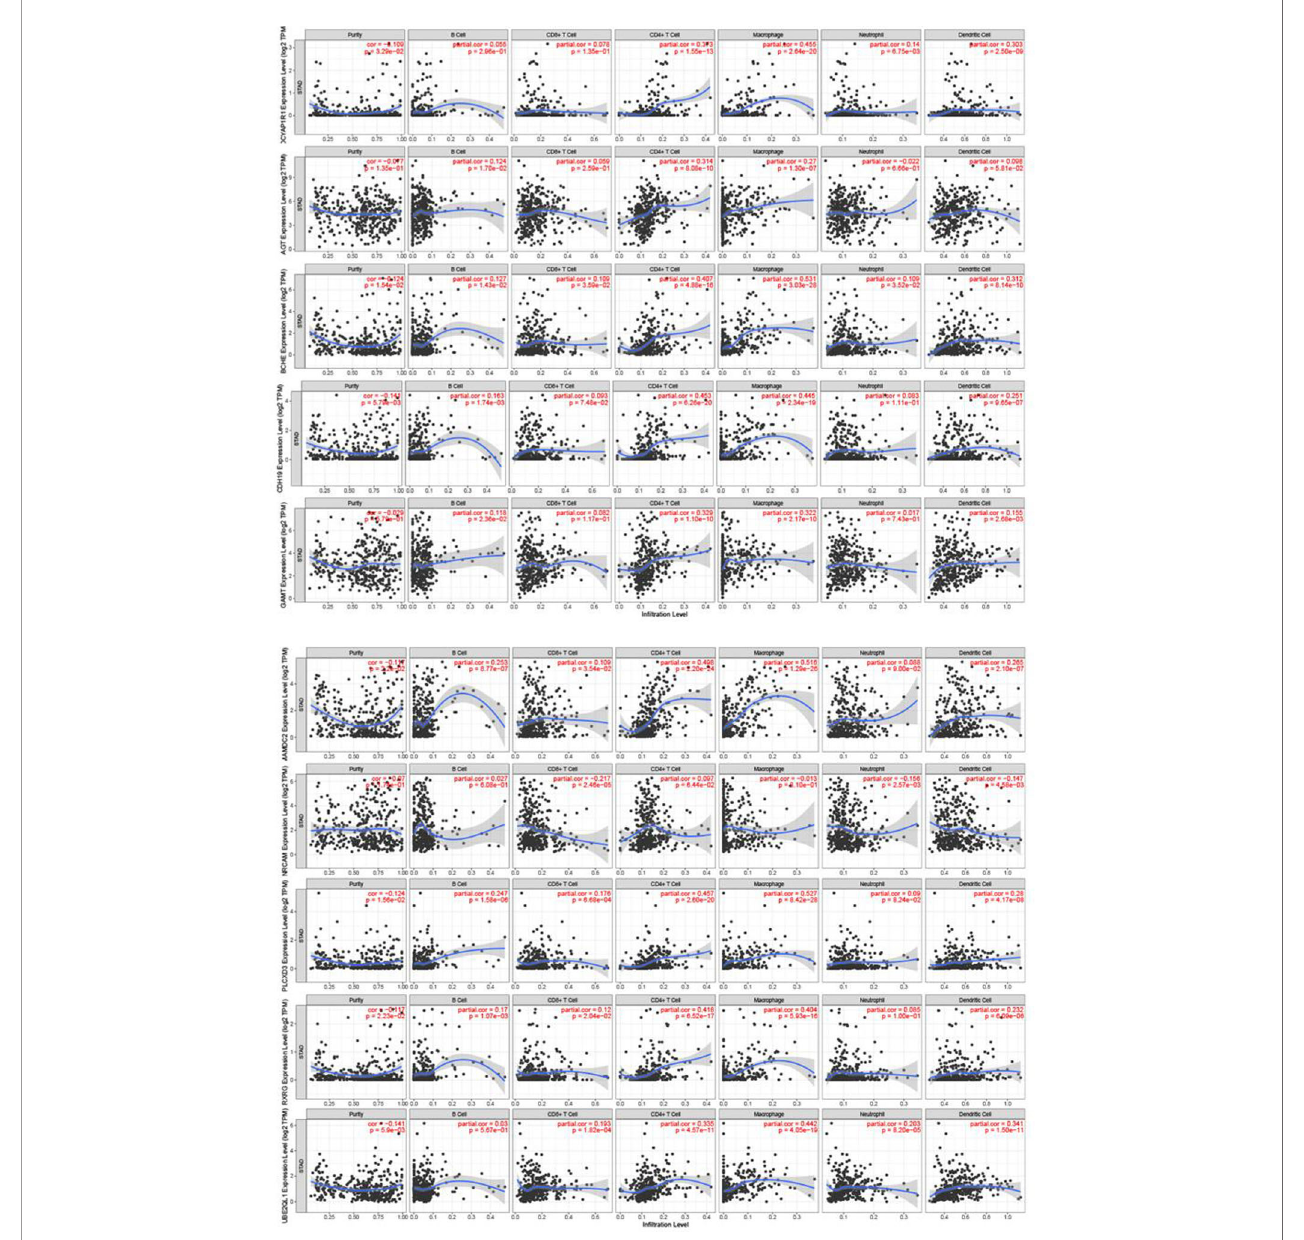
FIGURE 7 | 10 Relationship between gene expression and immune